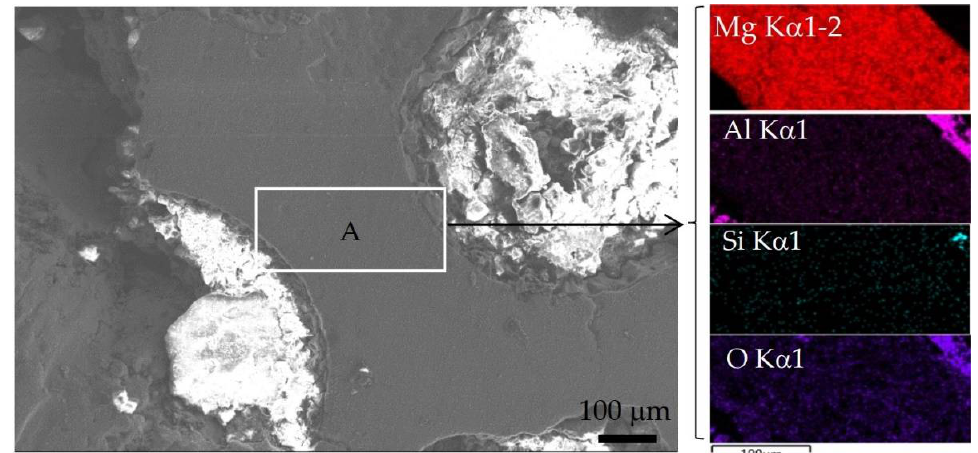
Figure 7. Local microstructure of Al 2 O 3hs /AZ91D prepared at 693 K and its elemental map.